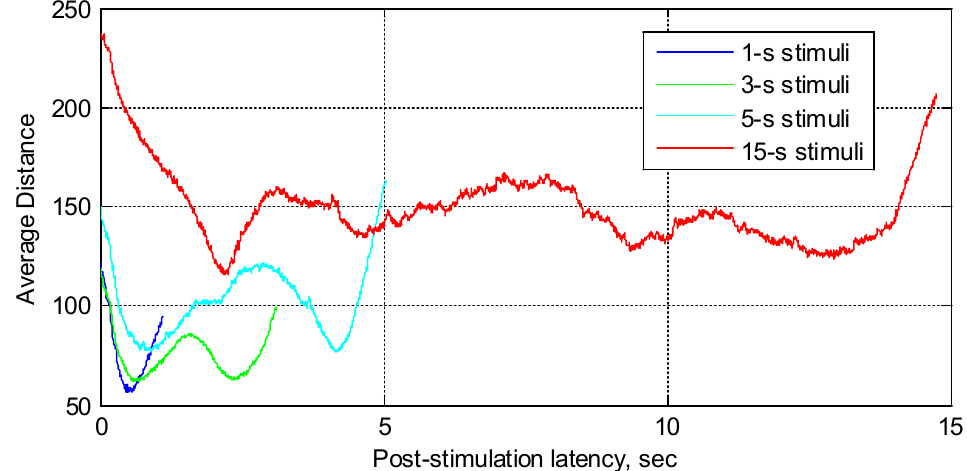
Figure 5. Distance averaged over 19 participants, 2 trials per participant, and all EEG channels and epochs as a function of post-stimulation latency. Table 1. A summary of processed EEG